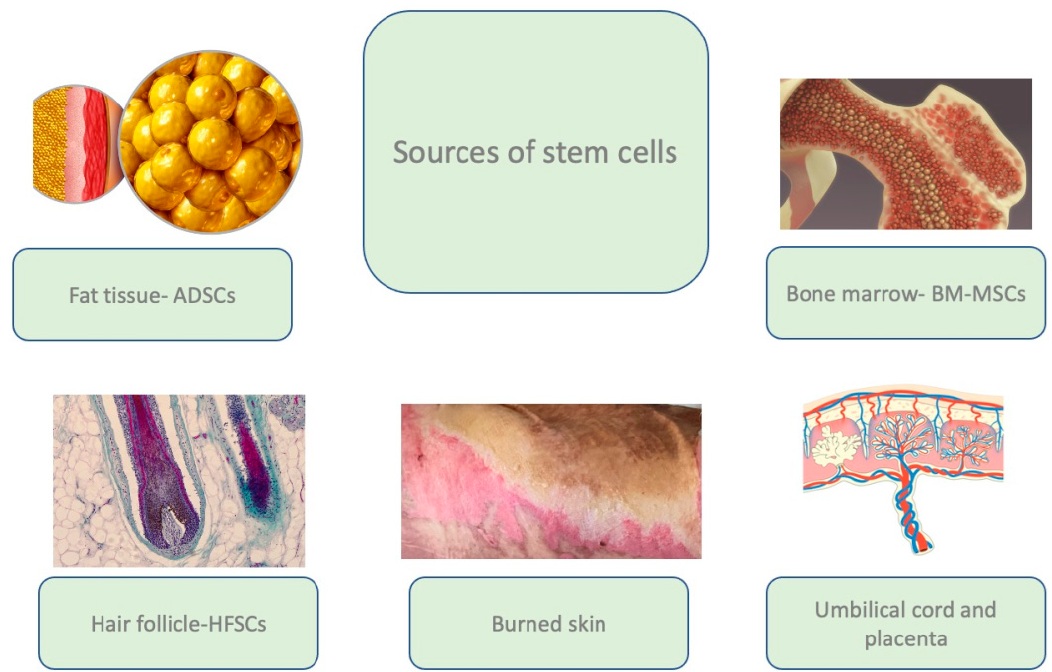
Figure 2. The main sources of adult stem cells used in bioengineering. Images purchased under the Adobe Stock License.